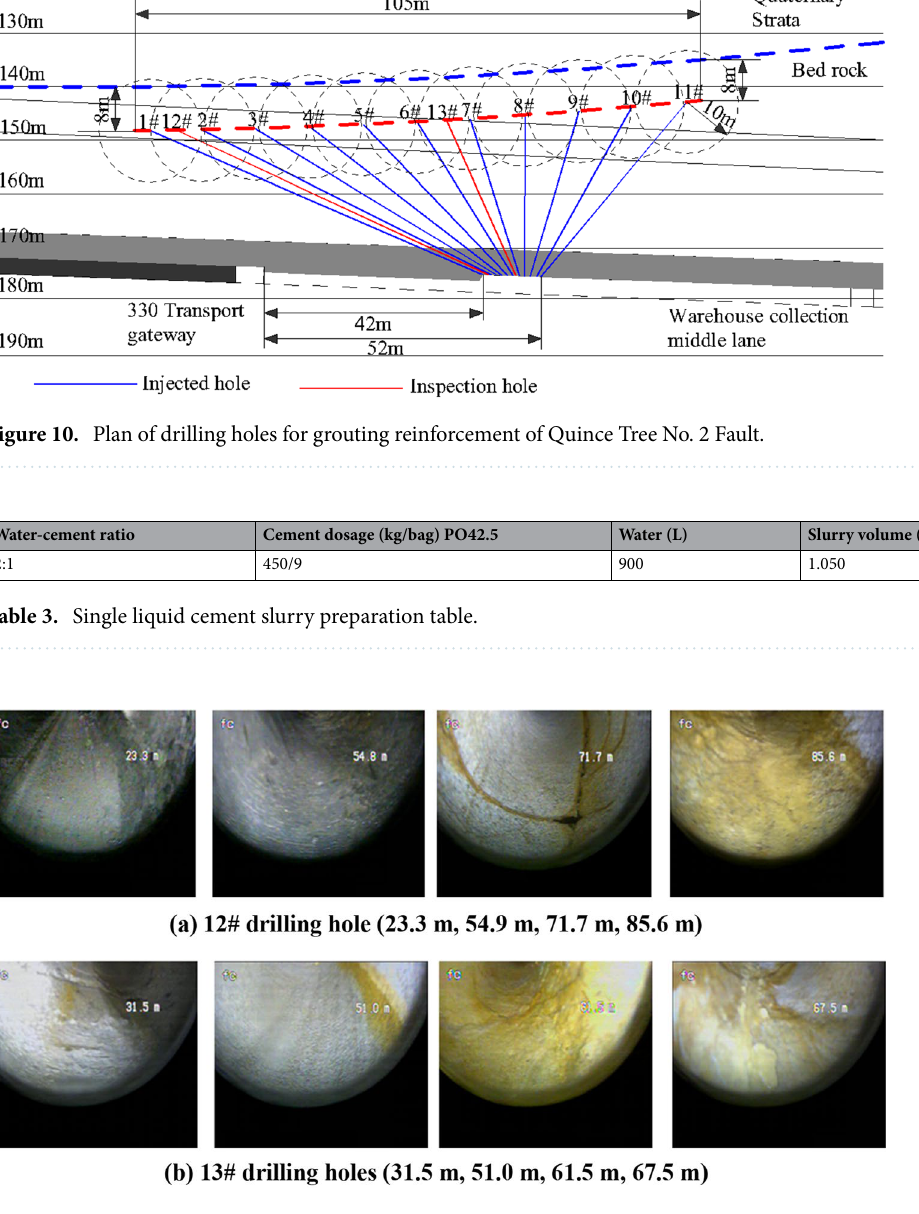
Figure 11. Inspection hole peep